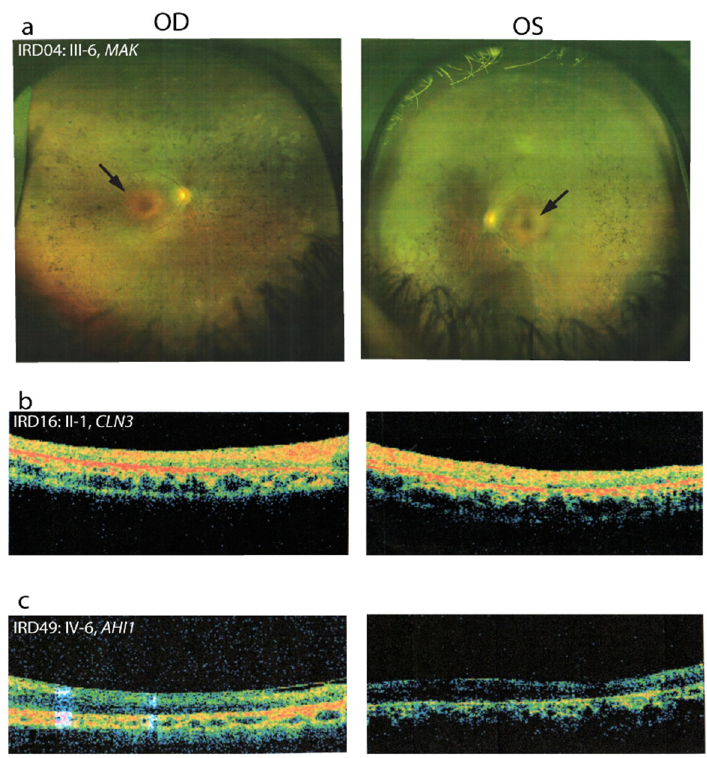
Figure 4. Optical Coherence Tomography (OCT) or fundus photography of both eyes for identified families with interesting genotype-phenotype correlations: ( a ) fundus photography for patient IRD04: III-6, arrow points to bull’s eye maculopathy; ( b ) patient IRD16: II-1 OCT showing loss of foveal reflex with generalized macular thinning, no cystoid macular edema or vitreoretinal interface abnormalities or epiretinal membrane; ( c ) patient IRD049: IV-6 OCT showing severe thinning and atrophy.